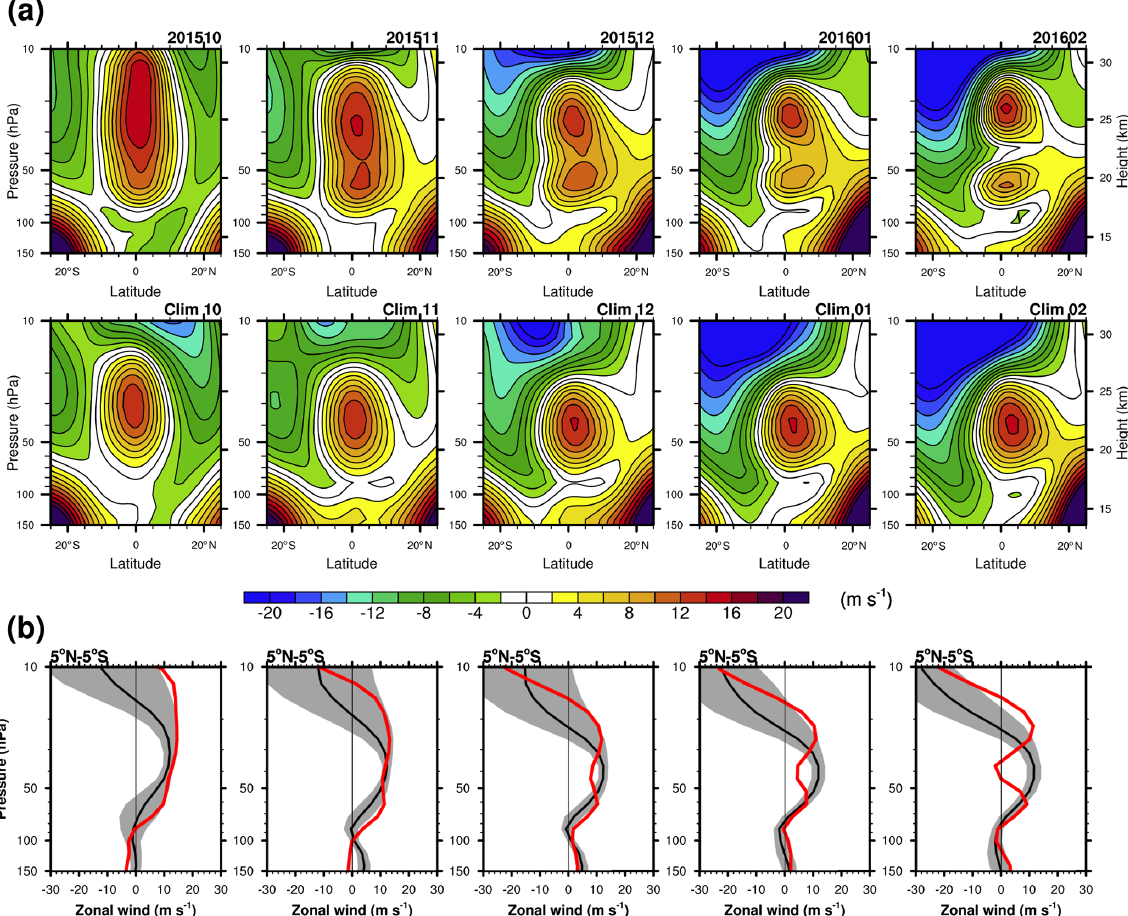
Figure 1. (a) Latitude–height cross sections of the zonal-mean zonal wind from October 2015 to February 2016 and (bottom) their climatol- ogy in each month from October to February. (b) Zonal-mean zonal wind averaged between 5 ◦ N and 5 ◦ S from October 2015 to February 2016. Red lines represent the QBO disruption and black lines represent the climatology with ± 1SD (gray shading). Note that the climatology is for WQBO